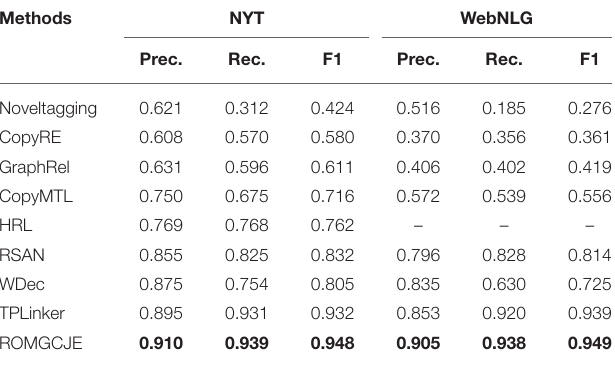
TABLE 3 | Comparison results of ROMGCJE with other models.